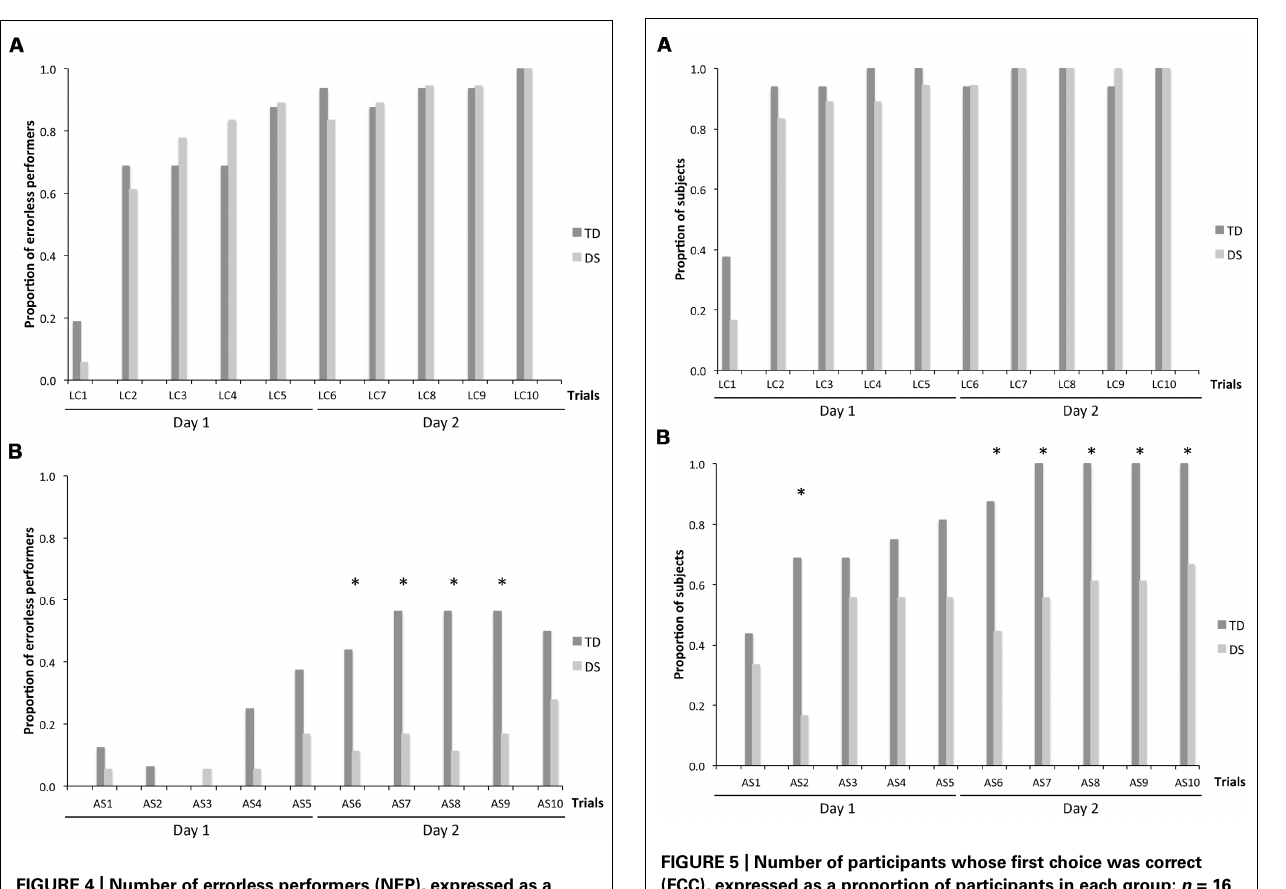
FIGURE 4 | Number of errorless performers (NEP), expressed as a proportion of participants in each group: n = 16 forTD participants and n = 18 for participants with DS. (A) LC trials. (B) AS trials.The asterisks denote statistically significant group differences on a given trial at p < 0.05.